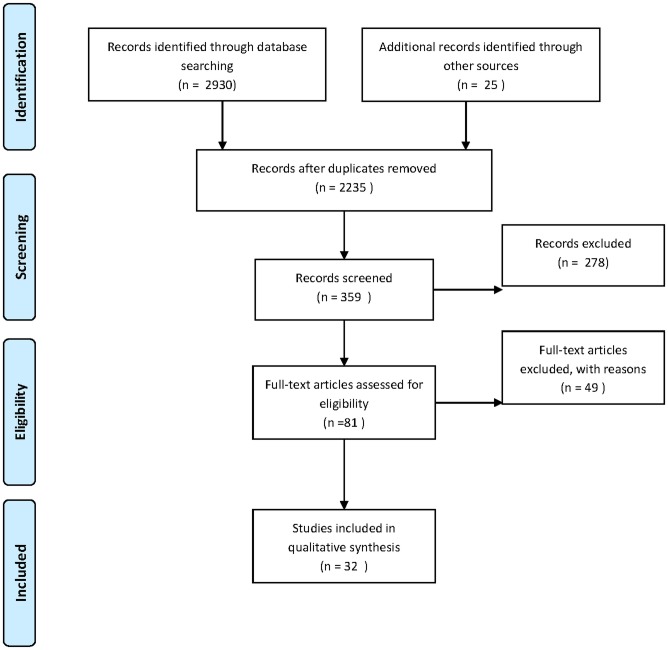
PRISMA flow diagram.